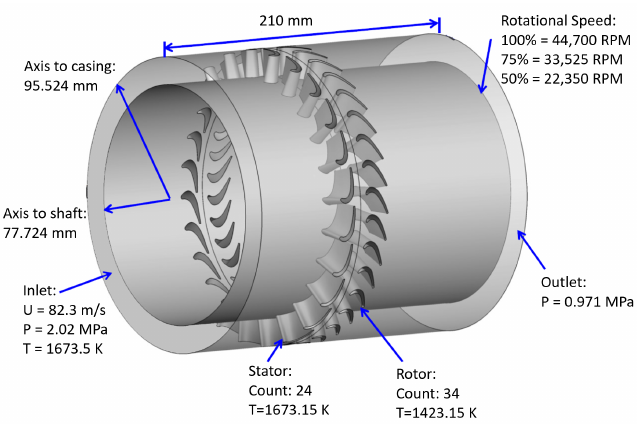
Figure 4. CAD model of a single stage power turbine sector with baseline dimensions and boundary conditions